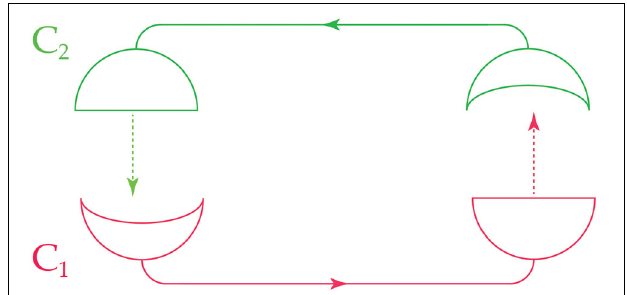
FIGURE 3 | Two adjacent conscious agents, C 1 and C 2 . Each agent receives messages from the other (indicated by the concave receivers) and sends messages to the other (indicated by the semicircular transmitters). Arrows show the direction of information flow.